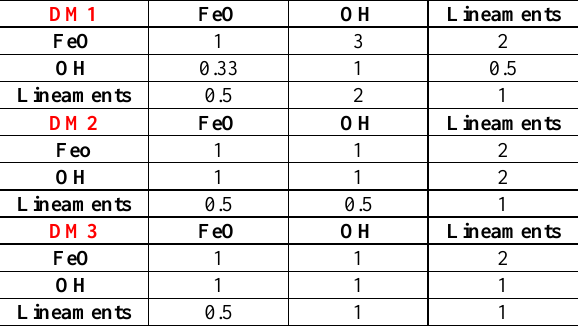
Table 1. Pairwise comparison matrices for evidential layers of remote sensing criteria.